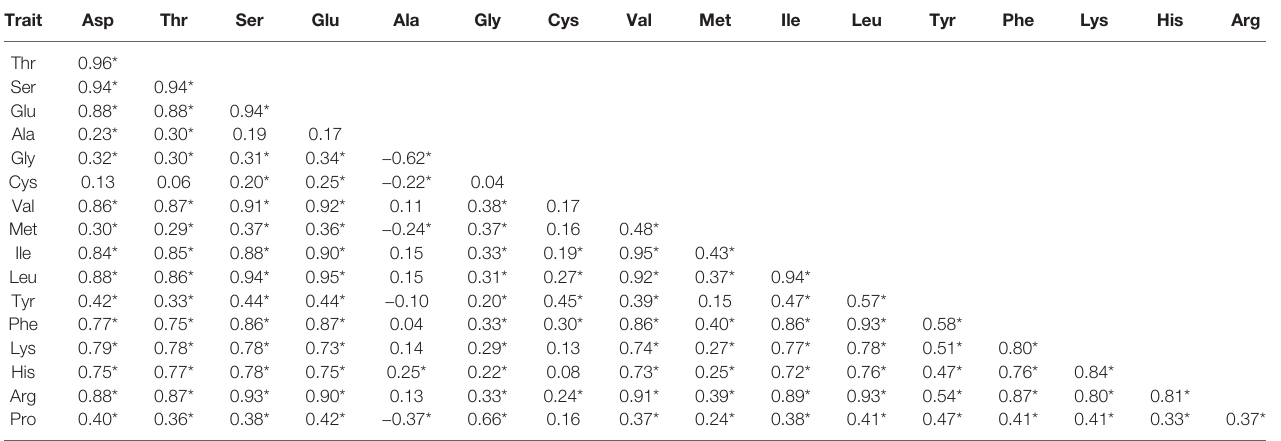
TABLE 2 | Pearson correlation coef fi cients between 17 components of AAC in the ZS97/MY46 recombinant inbred line (RIL) population. Trait